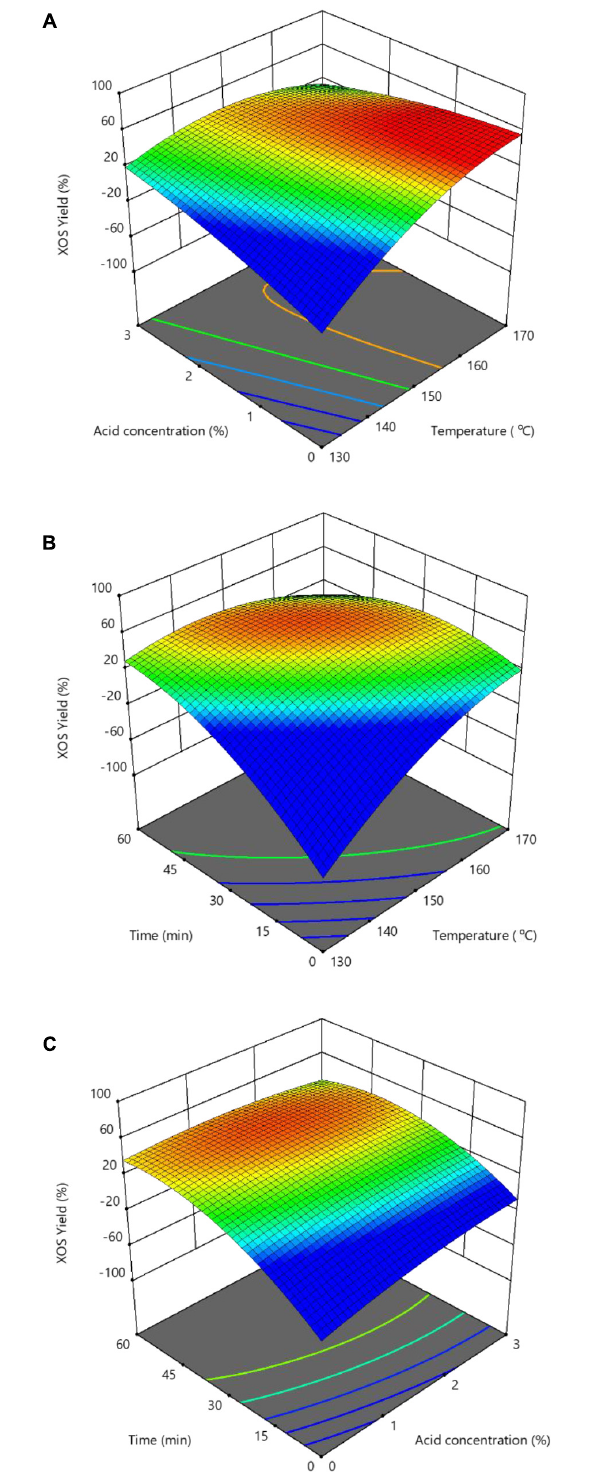
FIGURE 3 | Response surface showing the effects of independent variables on XOS yields: (A) Reaction temperature and hydrolysis time; (B) Reaction temperature and FA concentration; and (C) Hydrolysis time and FA concentration. XOS, xylooligosaccharides; FA, furoic